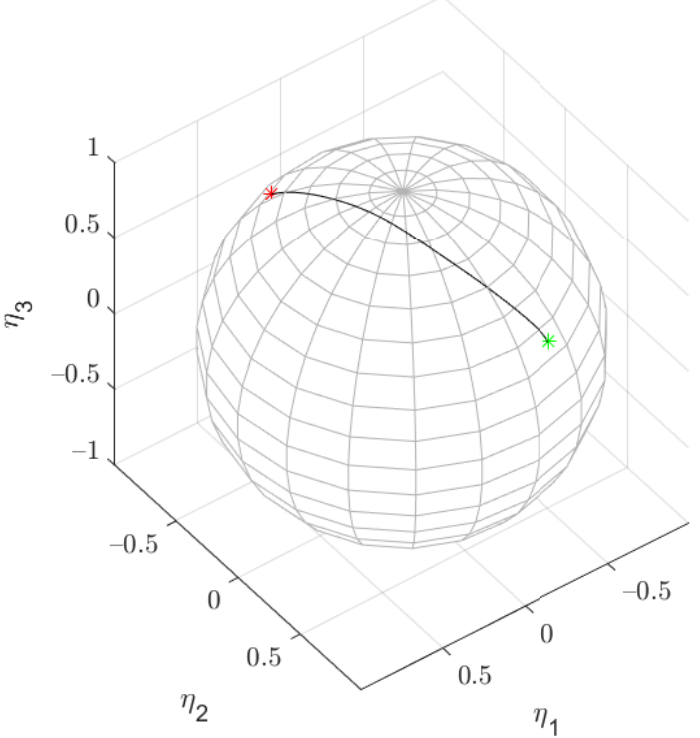
Figure 10. Path on the two-sphere for the 17 first seconds. Red asterisk marks the initial configuration, while the constant reference is marked